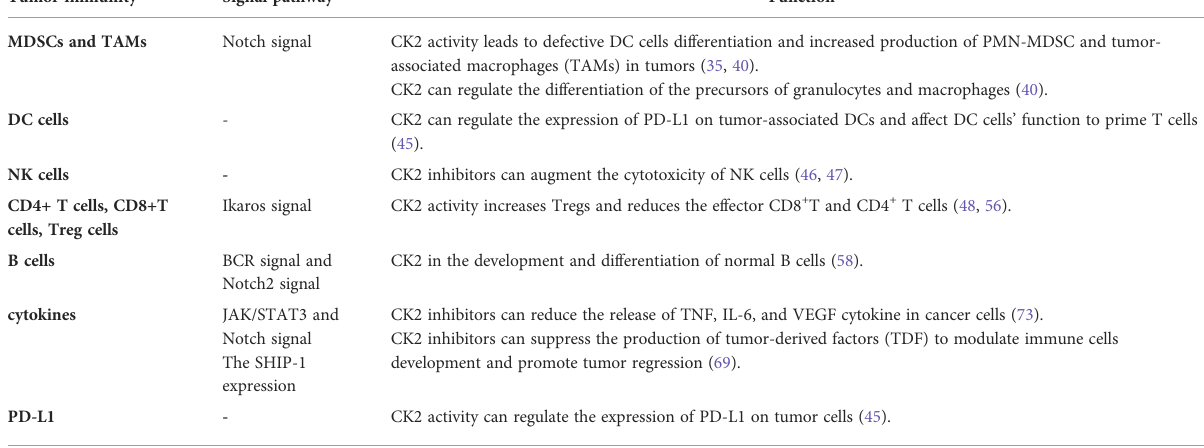
TABLE 1 Protein kinase CK2 and tumor immunity. Tumor immunity Signal